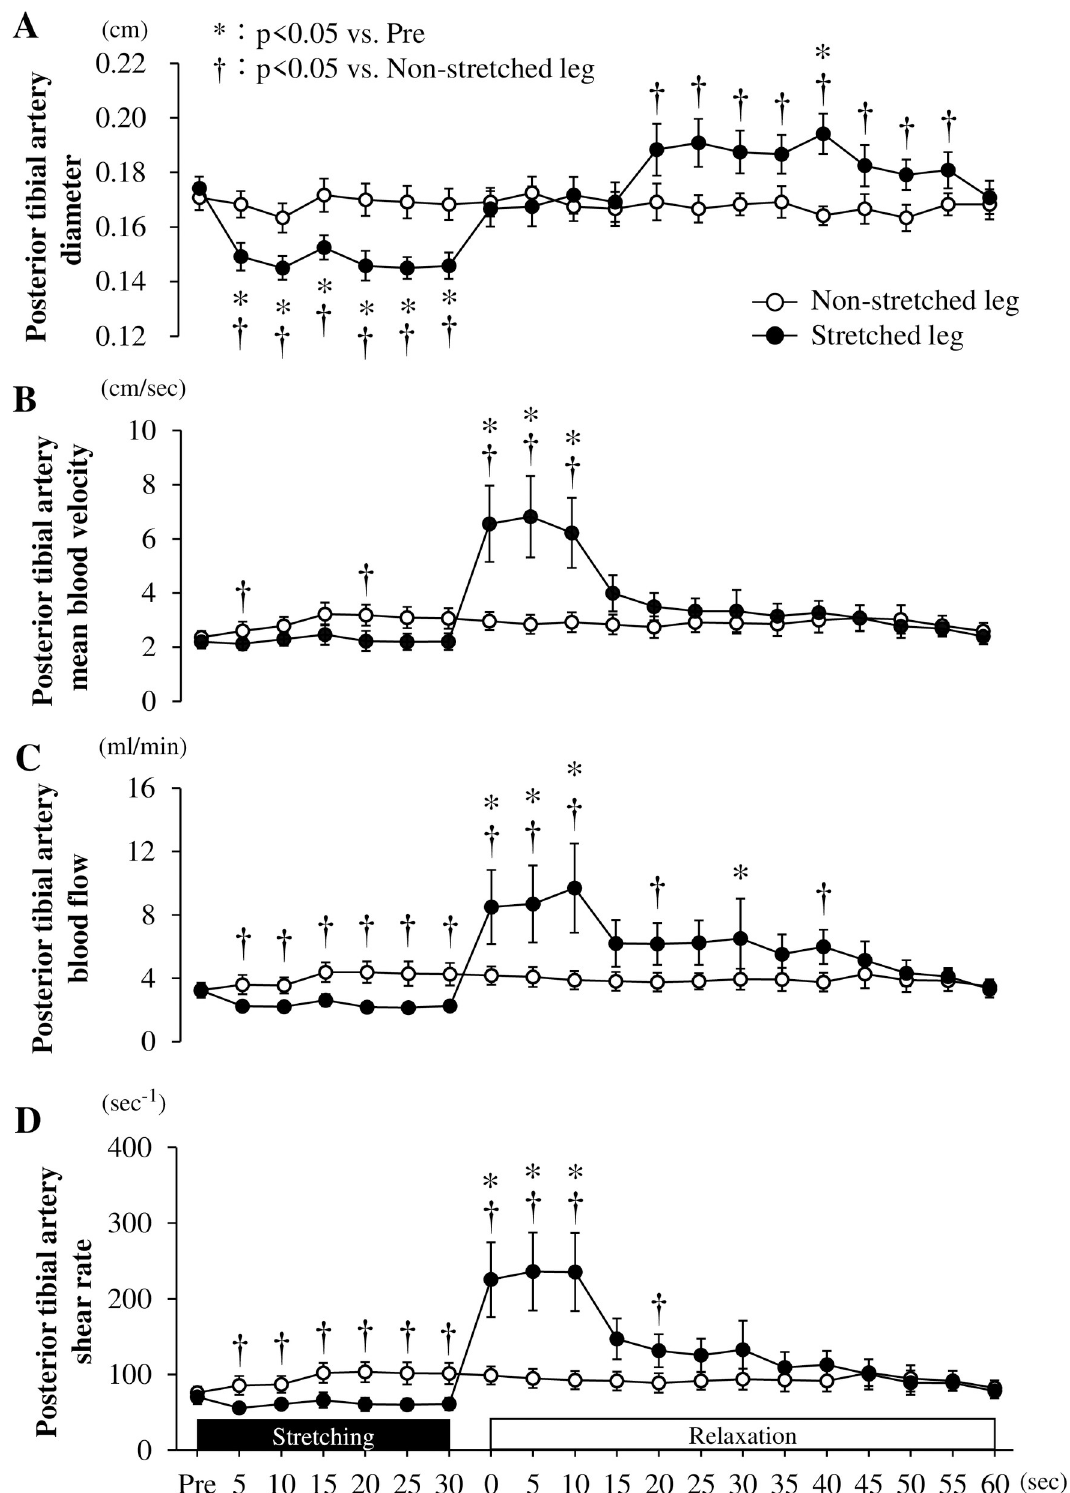
Fig 2. Artery diameter (A), mean blood velocity (B), blood flow (C), and shear rate (D) of the posterior tibial artery before, during, and after passive one-legged calf stretching. Pre, before stretching; � P < 0.05 vs. Pre, † P < 0.05 vs. Non-stretched leg. Data are presented as mean ±